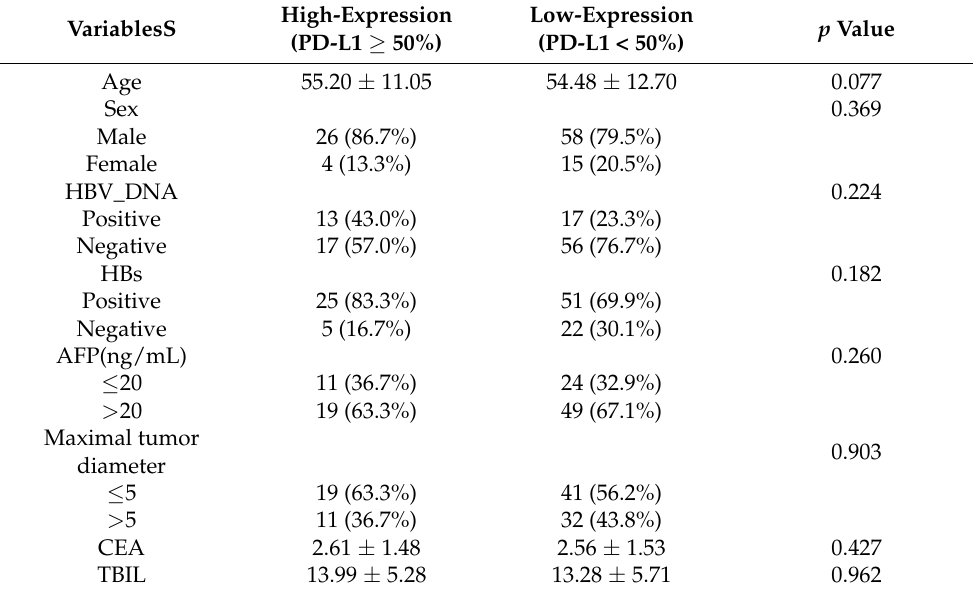
Table 2. Comparisons of clinicopathologic characteristics of HCC patients between PD-L1 high- expression group and low-expression group.